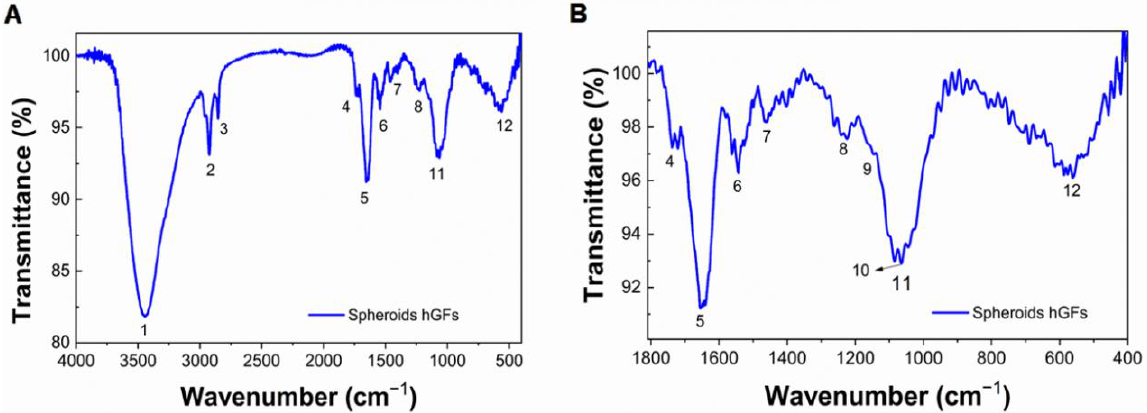
Figure 5. FTIR spectrum of hGF spheroids. ( A ) Fourier transform infrared (FTIR) spectrum of an hGF spheroid after 21 days of culture. ( B ) The range of 400 – 1600 cm − 1 corresponds to the zone of the FTIR spectrum fingerprint. Peak positions represent molecular vibrations characteristic of min- eral and organic molecular vibrations. The distribution of the mineral components of hGF spheroids showed v1 – v3 [CO 32 − ] (peak 7) at~1423 and 1404 cm − 1 , v1 – v3 [PO 42 − ] (peak 11) at~1064 cm − 1 , and v4 [PO 43 − ] (peak 12) at~557 cm − 1 , and organic molecular vibrations (Sugar ring stretch C-O, peak 10) corresponds to carbohydrate-proteoglycan functional groups (arrow).